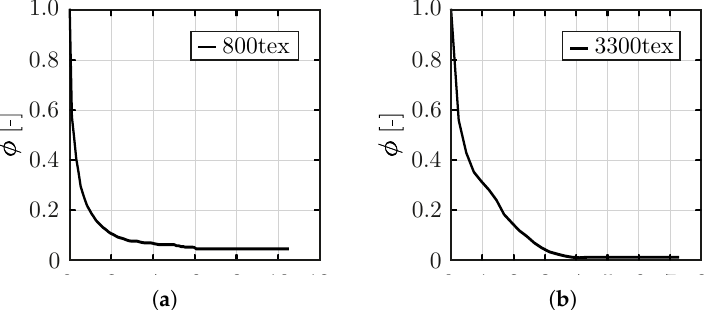
Figure 13. Damage functions describing the matrix cracking calibrated using the matrix stress–strain curve in Figure 11 extracted from the composite tensile tests with ( a ) 800 tex and ( b ) 3300 tex.